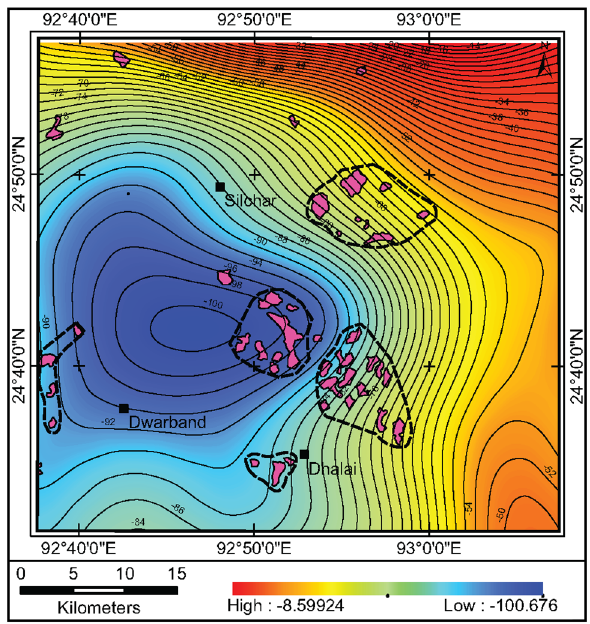
Fig. 12 Satellite gravity map of the study area. Contours are at 2-mGal interval. Remote sensing-derived hydrocarbon microseepage prospect areas are shown as